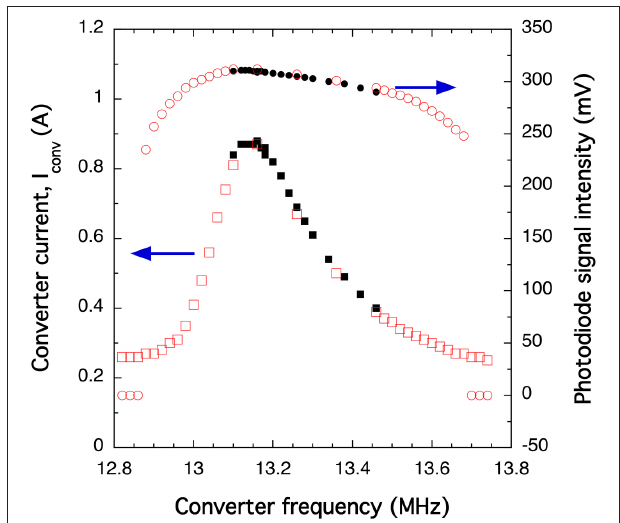
FIGURE 4 | Converter current I conv (open red squares and filled black squares) and photodiode voltage (open red circles and solid black dots) vs. operating frequency for the IRUKANDJI atmospheric pressure test configuration of Figure 1 ; gas flow rate is 19 sccm with CW operation at P MiniPR ∼ 14 W; the plasma is kept “on” between measurements, in CW mode for the open red symbol data sets and in pulsed mode at 20 kcycles for the filled black symbol data sets; the gate current is 0.2 A during CW